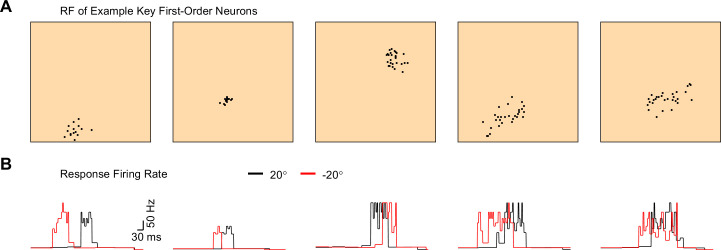
Receptive field and response rate of first-order neurons contributing to edge-orientation classifiers.A. The locations of innervated mechanoreceptors (black) in five example first-order model neurons from the population, which formed key excitatory synaptic weights in an edge-orientation classifier unit tuned to 20° and using fast-decaying (AMPA) synapses. The classifier was of the type shown in Fig 4. The skin patch dimensions are as in Fig 2. B. The firing rate of the example model neurons shown in A, in response to moving edges oriented 20° (black) and -20° (red), with a noise level of 5%.